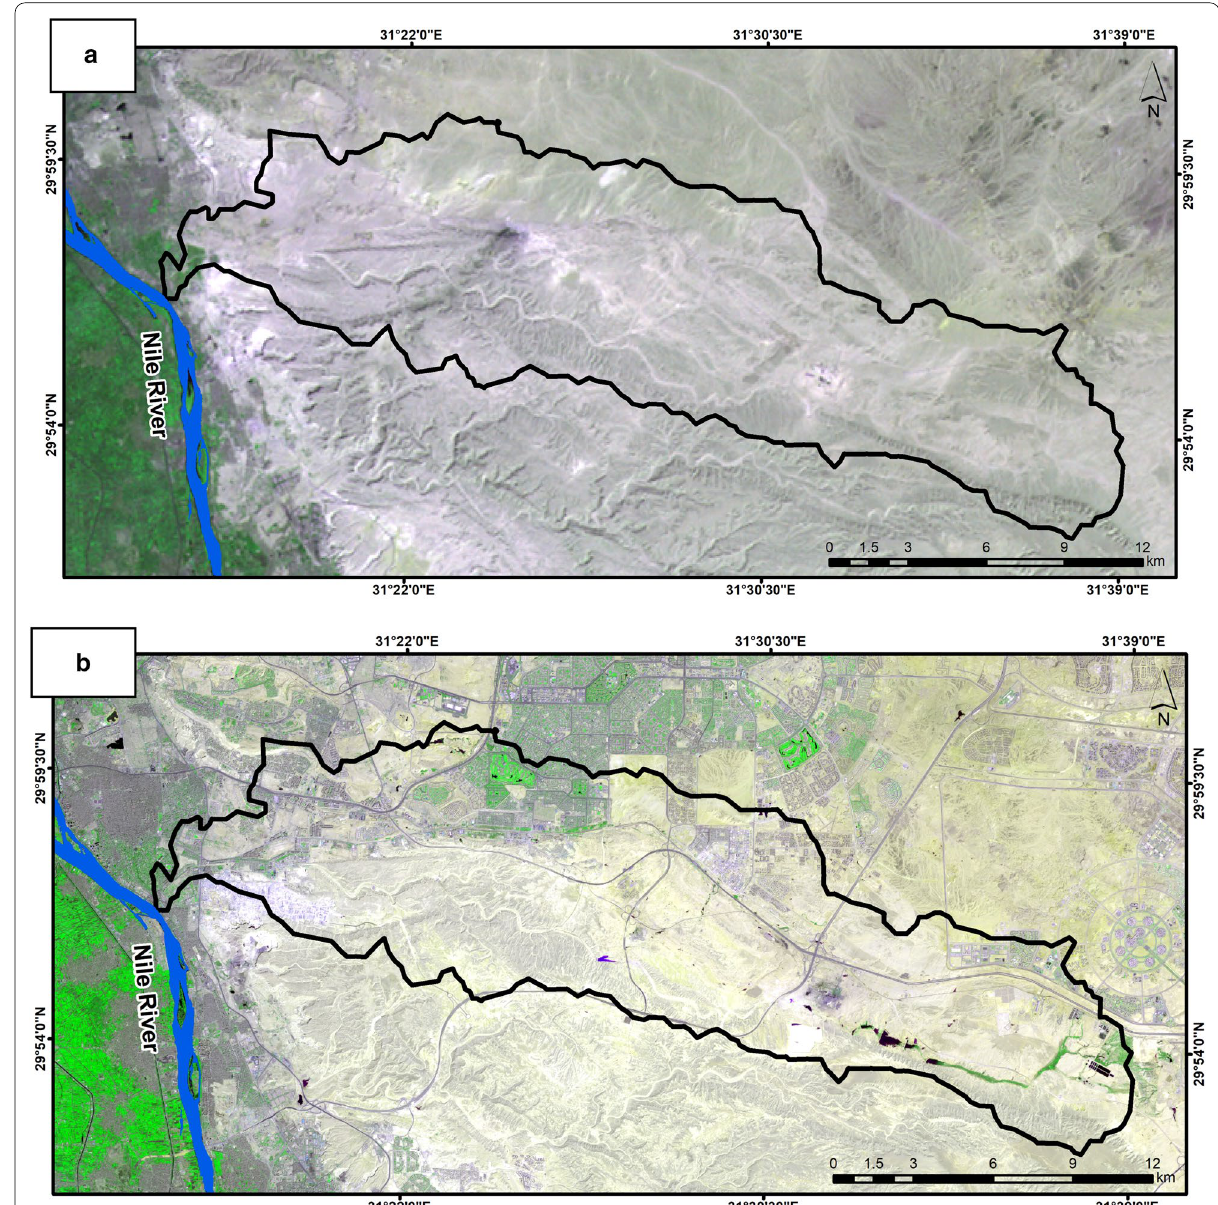
Fig. 4 Raw data of Landsat satellite images a Landsat 5, 1984 (bands 4/2/1) and b Sentenil-2, 2019 (bands